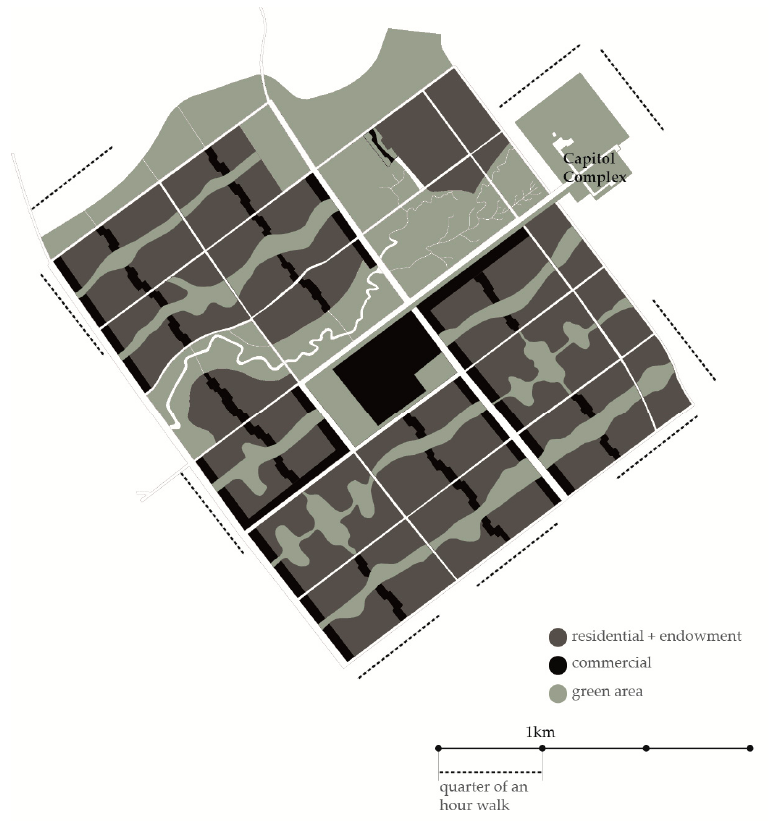
Figure 7. Chandigarh’s Master Plan. FLC05553. Source: © FLC/ADAGP .